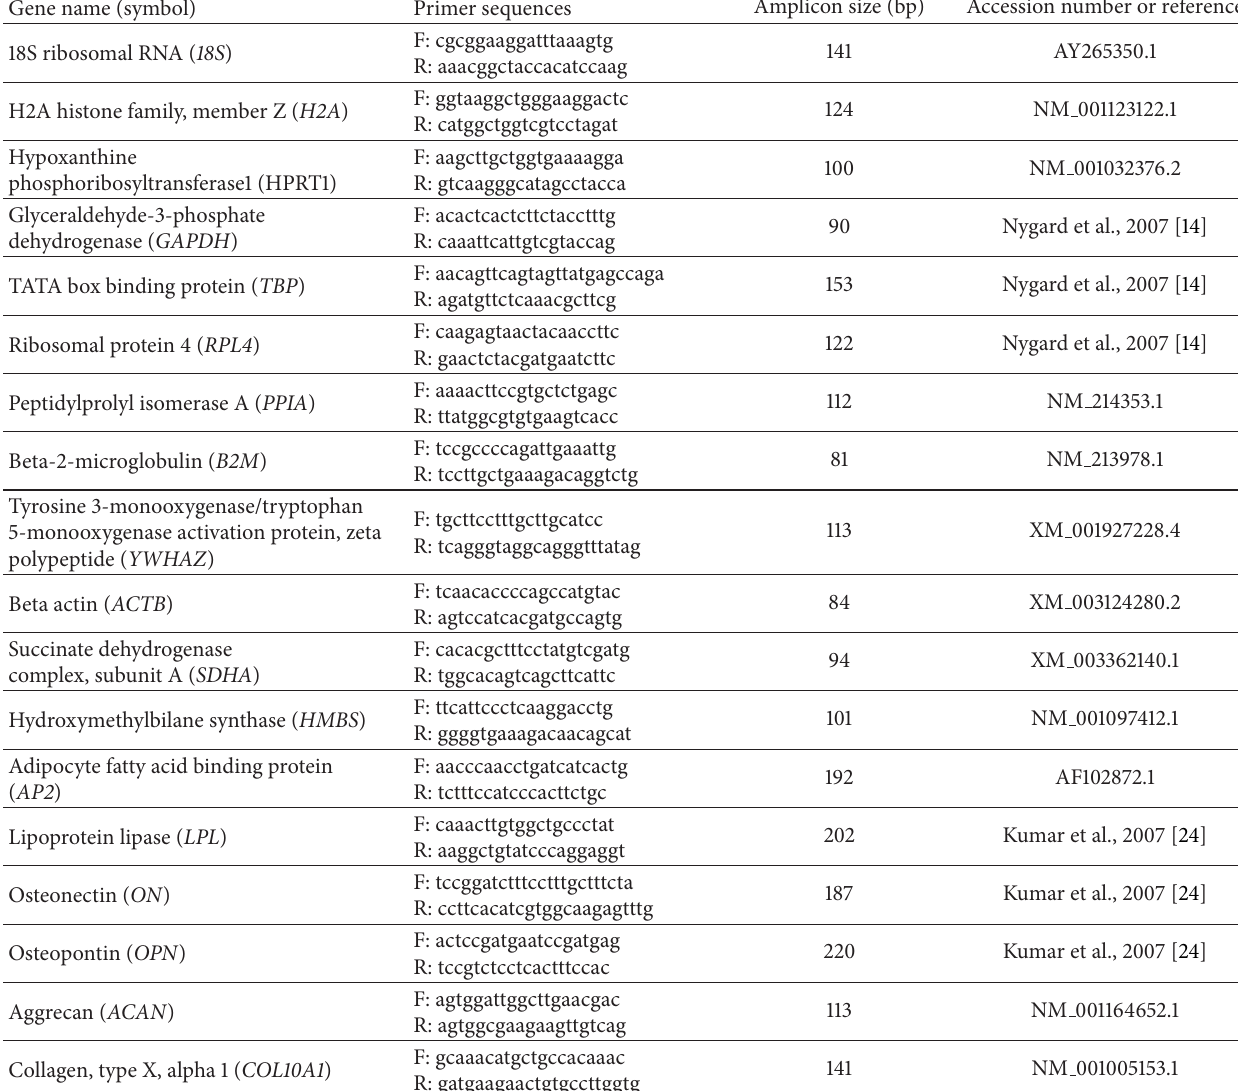
Table 1: Sequence of primers used for candidate of reference genes and the evaluation of lineage specific